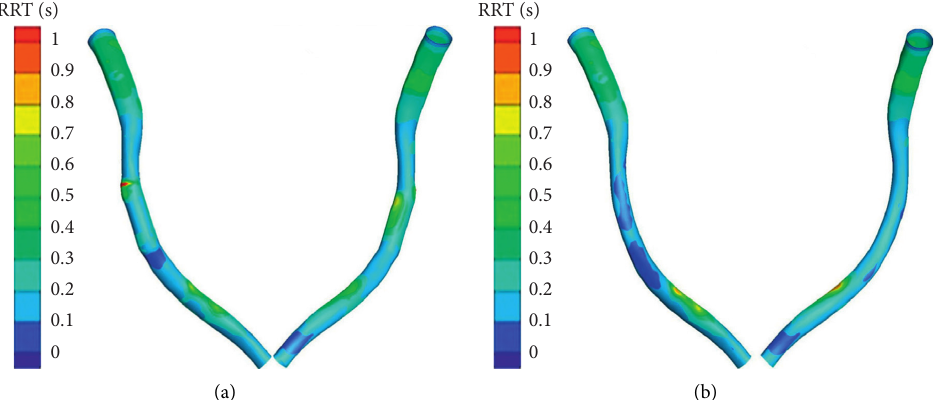
Figure 9: Counters of relative residence time (RRT): (a) straightening; (b)